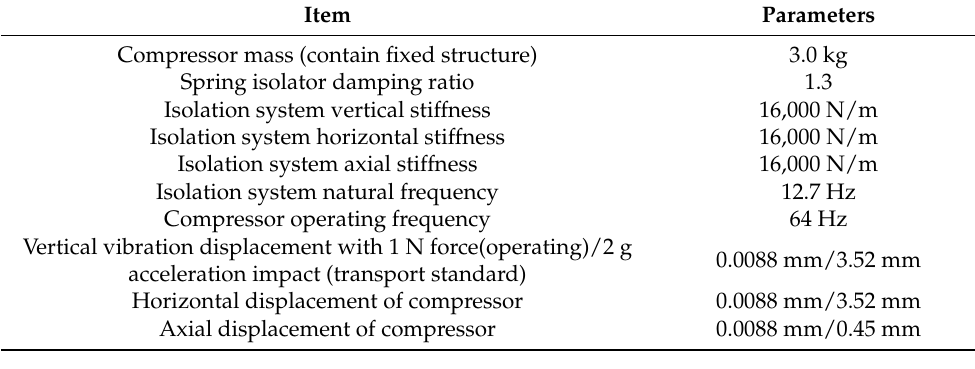
Figure 2. The physical model of the linear single-degree-of-freedom spring and damper system. Table 2. The compressor isolation system parameters.